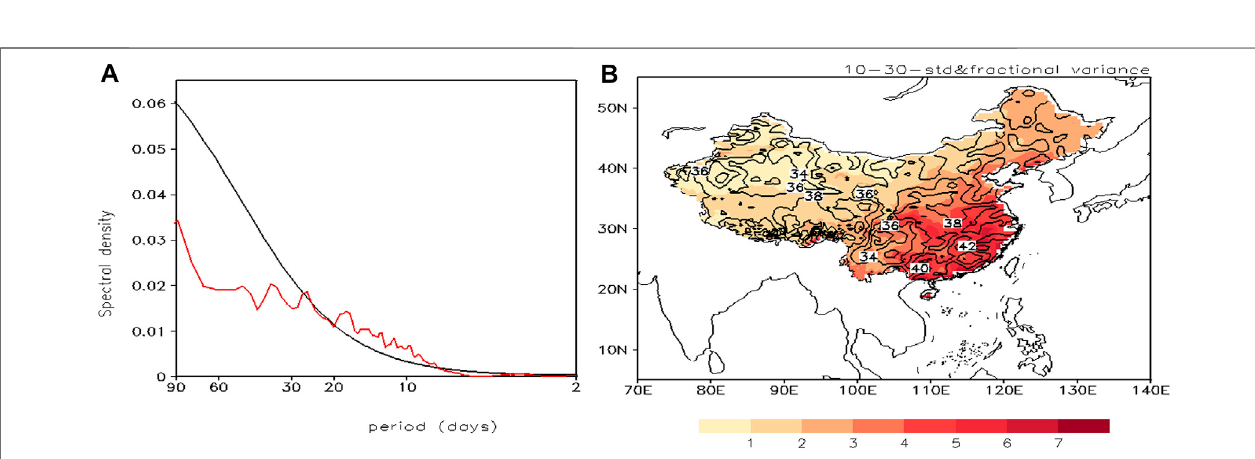
FIGURE 2 | Power spectrum diagram of summer rainfall (A) in southern China (24 – 32 ° N, 108 – 122 ° E) from 1979 to 2012; the mean square deviation [ (B) , shaded, unit: mm/d] and the fractional variance [ (B) , contoured, unit: %] of 10 – 30-day fi ltered precipitation. In (A) , the red line is the power spectral density, and the black line indicates the values of 95% con fi dence level.